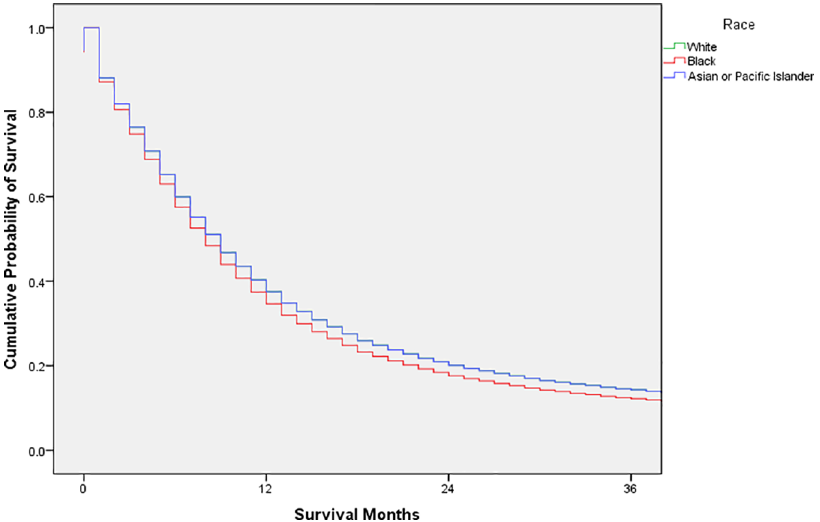
Fig 1. Adjusted survival curves, by race, for adult patients in the SEER database diagnosed with esophageal squamous cell carcinoma, 1973–2013.